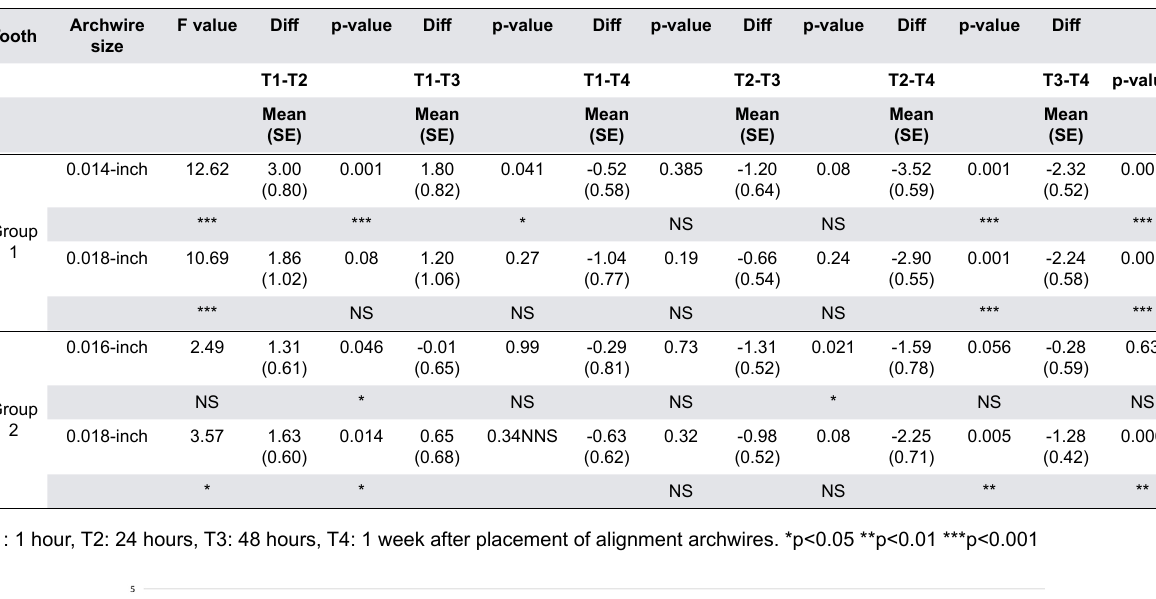
Table 7- Diff. between means and p-values for the pain scores at the different time points in each archwire size group